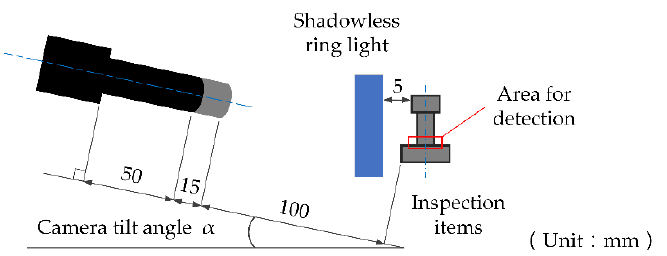
Figure 2. Illustration of the customized light source detection system with positioning distance.